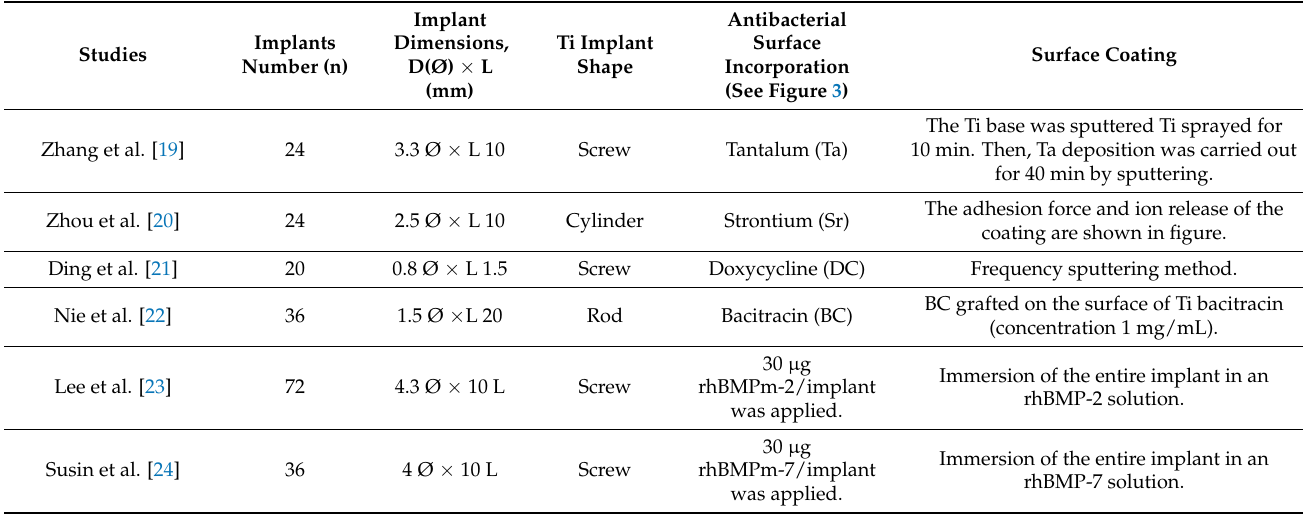
Table 2. Characteristics of implants.